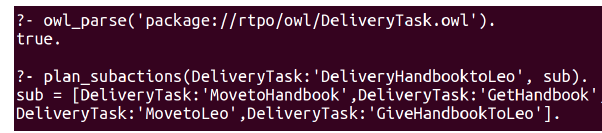
Figure 18. The snapshot of the query sentence from the ROS terminal.